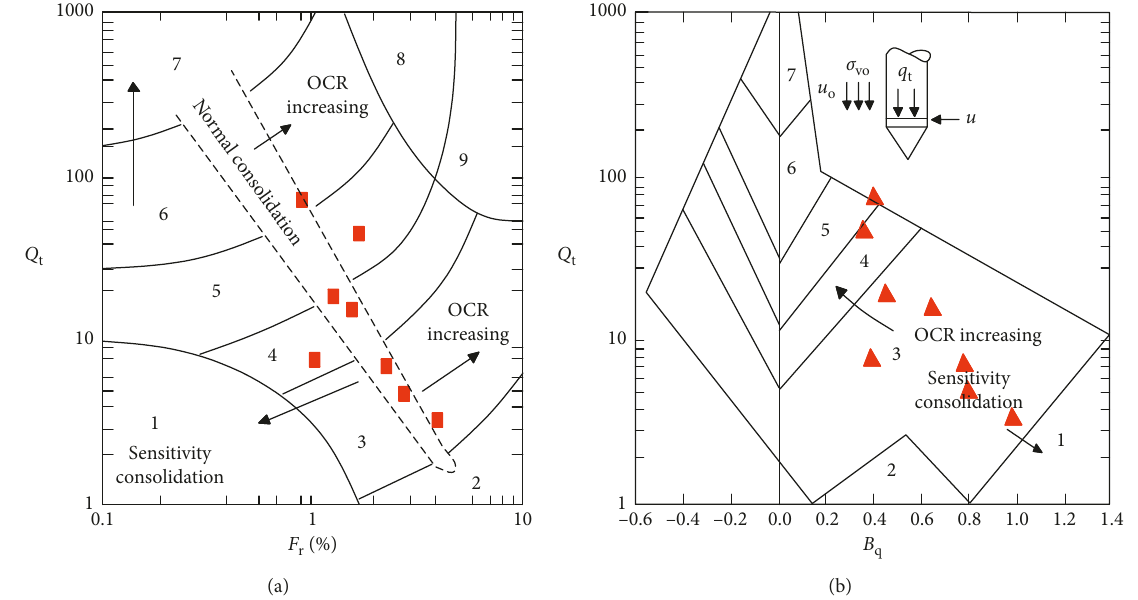
Figure 6: Soil classification using the method of Robertson [49].